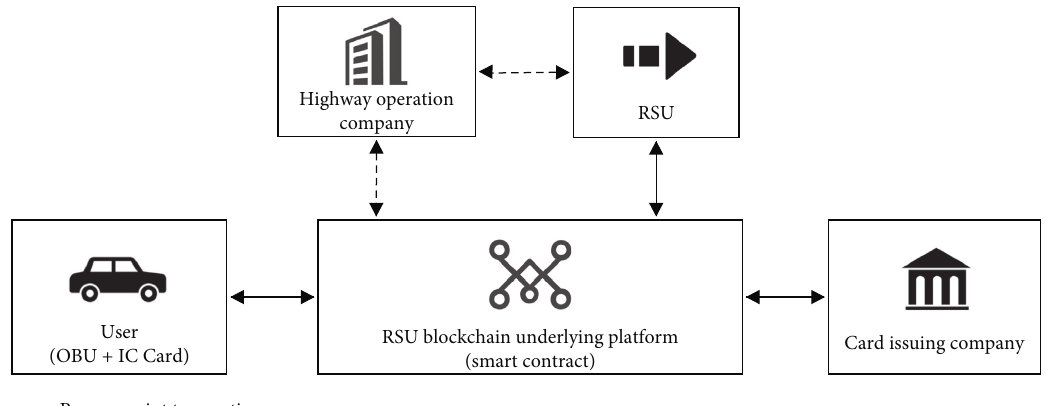
Figure 3: Framework of the blockchain-based ETC system.